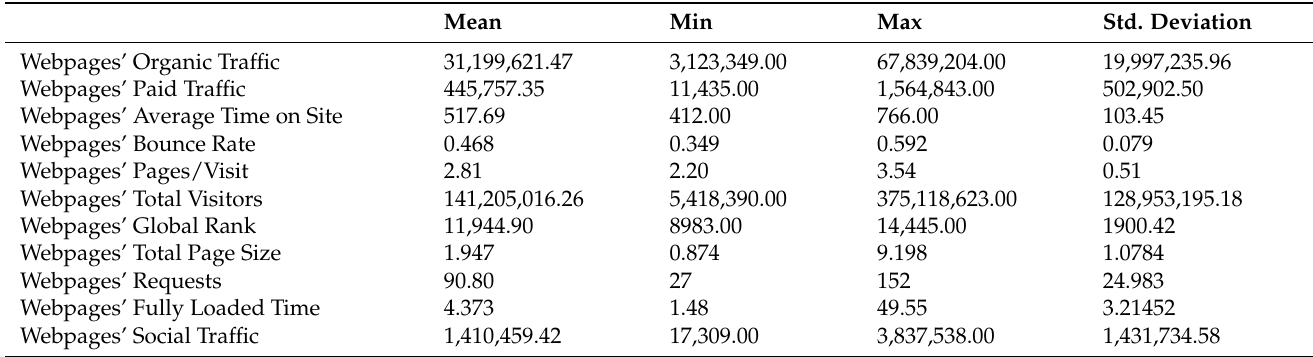
Table 2. Descriptive Statistics for 7 logistics webpages during 180 consequent